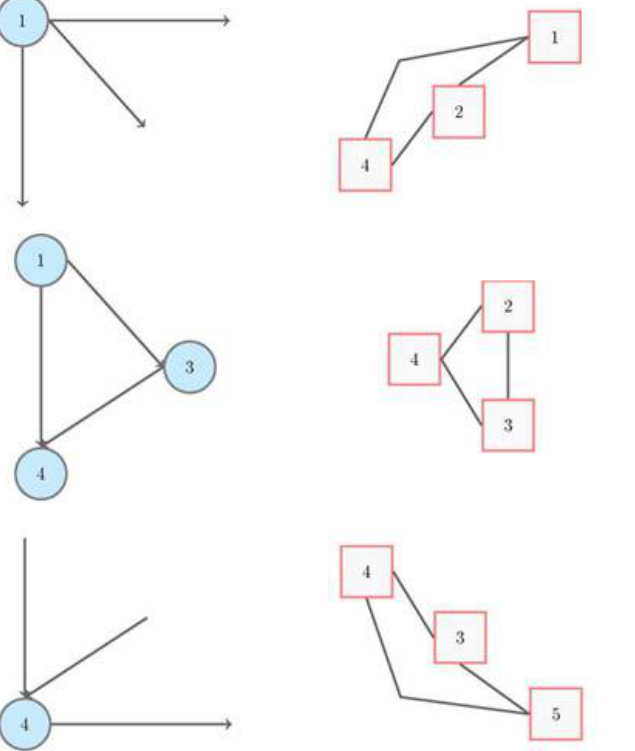
Figure 2. The cliques’ correspondence of the edge graph (on the right) to the sections of the original graph (on the left).